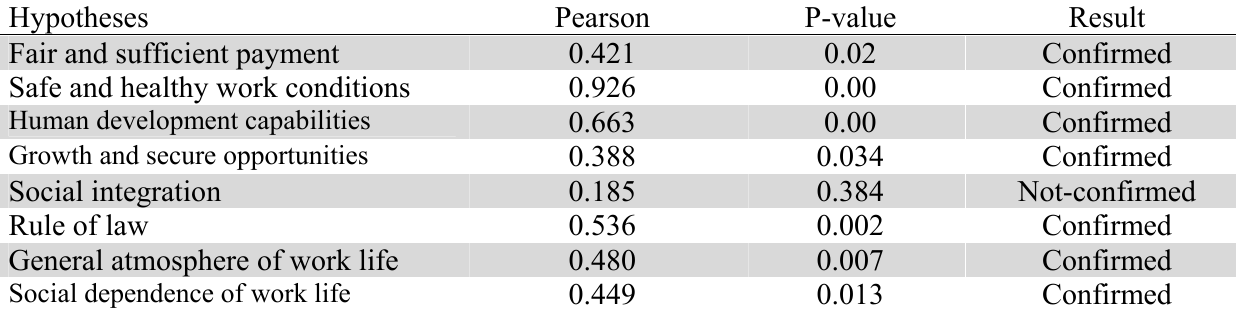
The summary of testing sub-hypotheses